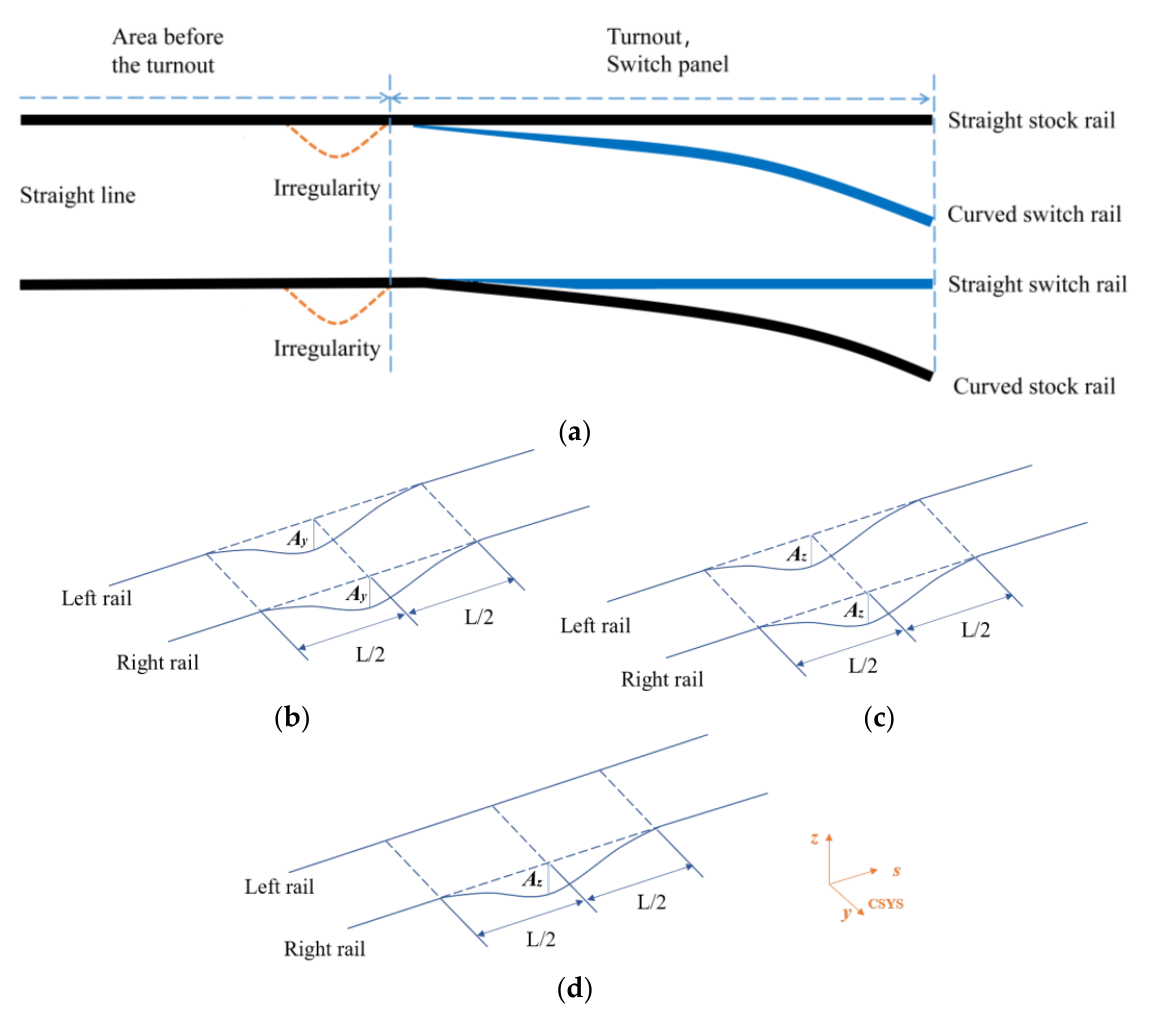
Figure 10. Schematic diagram of irregularity setting: ( a ) the applied position of the track irregularities; ( b ) AL; ( c ) LL; ( d ) CL.